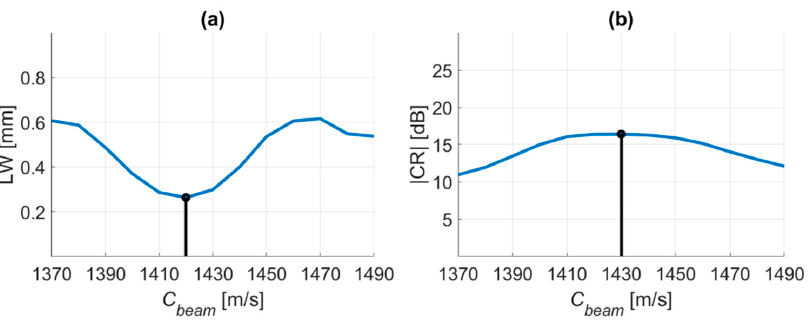
beam for the Prodigy